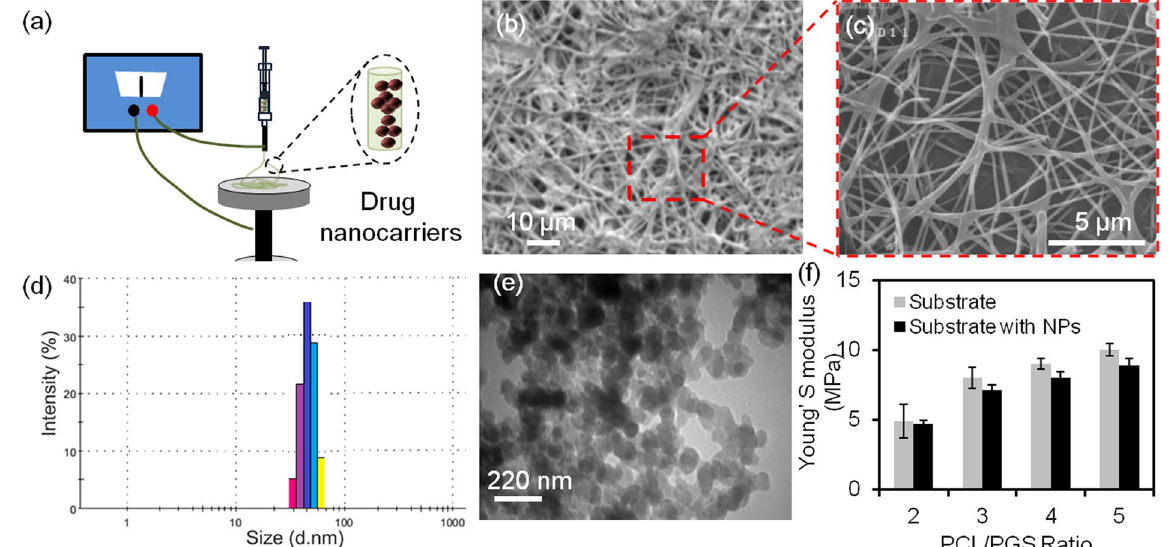
Figure 2. Fabrication of the elastic biodegradable nanofibrous drug delivery platform. ( a ) Schematic of the fabrication of the substrate by electrospinning ( b , c ) Representative SEM images of a typical nanofibrous substrate containing drug nanocarriers. ( d ) Size distribution of the generated particles in wet conditions measured by DLS. ( e ) TEM image of PEGylated chitosan nanoparticles which represented the spherical shape of nanoparticles and particles size. ( f ) Effects of nanocarriers on the Young’s modulus of the nanofibrous substrate containing 10% (w/w) of